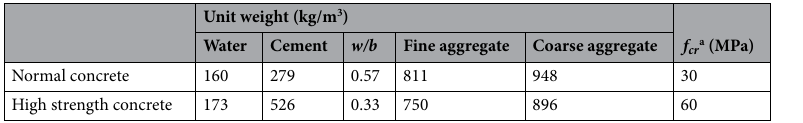
Table 2. Mixture proportions of concrete (by unit weight). a Is the required compressive strength of concrete.